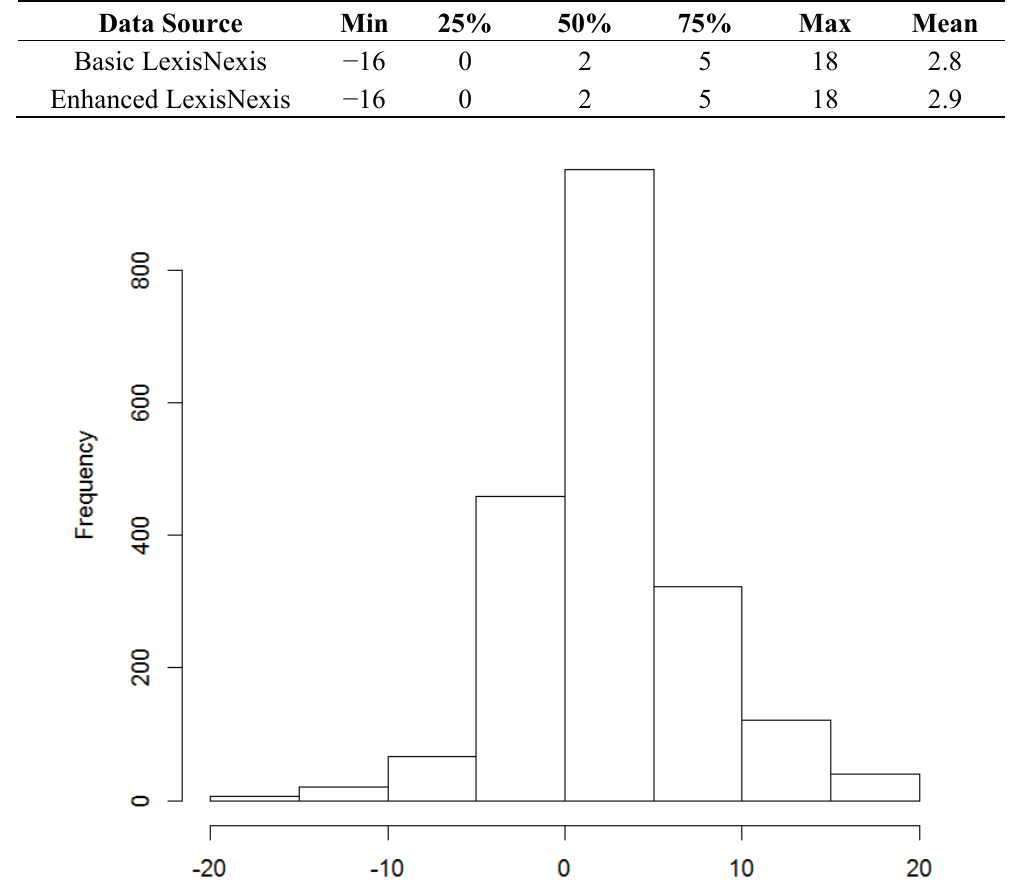
Table 4. Results for Metric 6 of the differences in time spent in years at each detailed